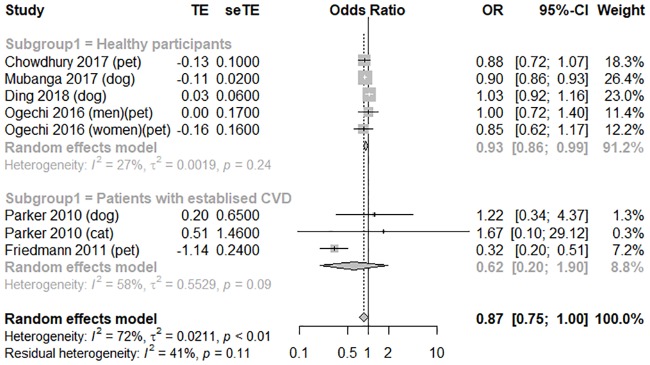
A forest plot of adjusted cardiovascular mortality, comparing pet owners and non-pet owners, with a subgroup analysis by participants health status.CI, confidence interval; OR, odds ratio; SE, standard error; TE, treatment effect.